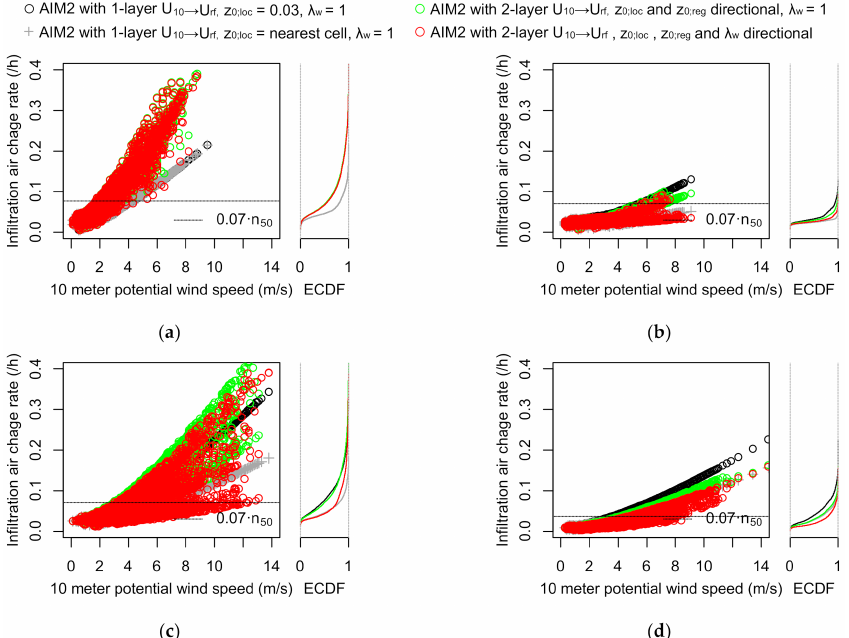
Figure 25. Calculated infiltration rate (air change per hour) over six months in winter versus 10-m wind speed in open terrain from reanalysis and estimated cumulative distribution (ECFD) ( a ) TWINS; ( b ) ZEBLL; ( c ) GBORO; ( d )